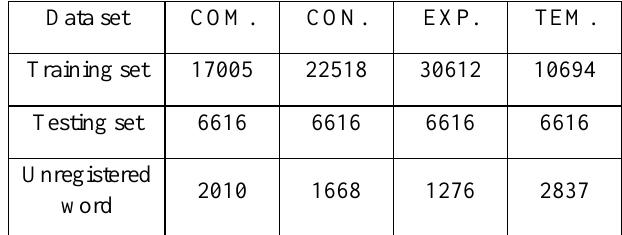
Table 4. Lexical distribution in four categories of discourse